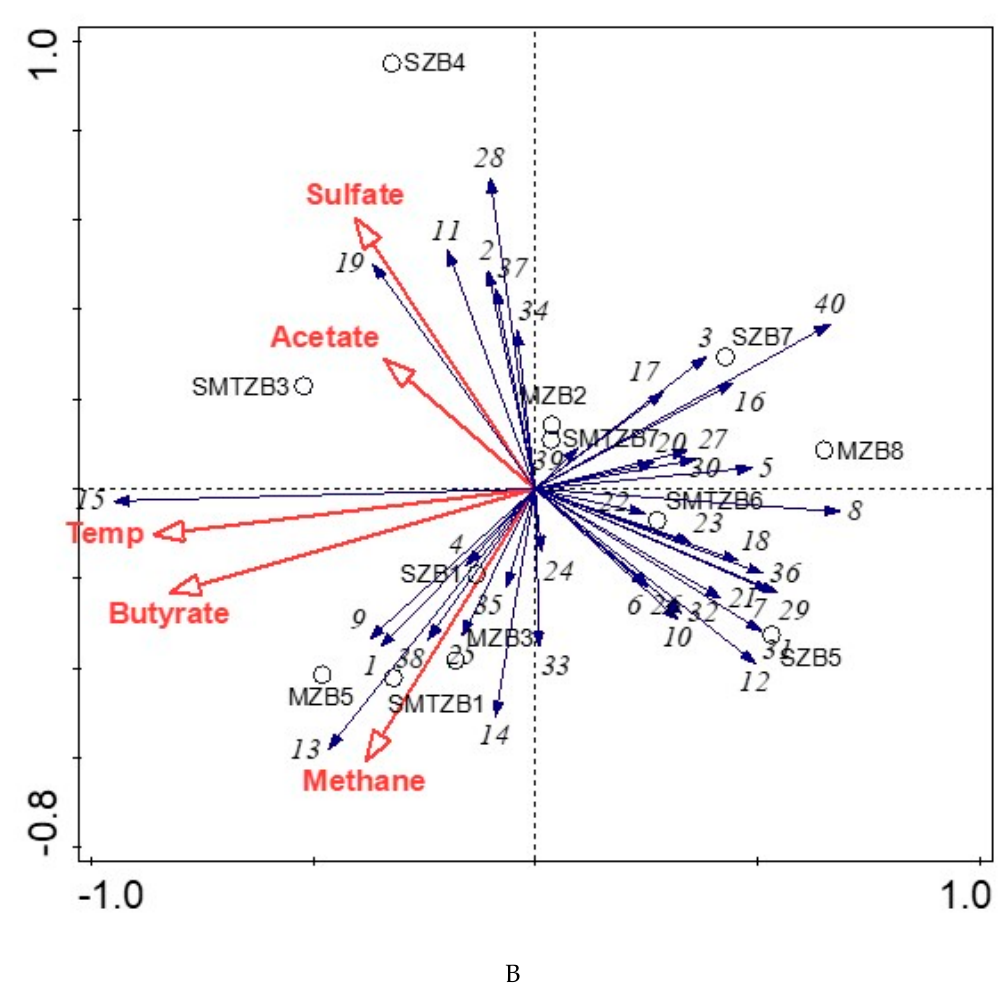
Figure 4. ( A ) The heatmap depicts the relative percentage of the most common (>5 %) bacterial 16S rRNA gene sequences across the 12 slurries analyzed. The heatmap colors represent the relative percentage of the bacterial assignments within each sample. Colors shifted towards dark green indicate higher abundance. Taxonomy is shown at the genus level (unless unassigned) above and at the phylum level below the heatmap. ( B ) Redundancy Analysis Triplot showing relationship between bacterial community composition at order level and environmental parameters. Environmental variables are given as red vectors. Blue vectors represent bacterial orders. Orders were included with a relative abundance of at least 1% in any sample. Vector length gives the variance that can be explained by a particular environmental parameter. Perpendicular distance reflects association, with smaller distances indicating a larger association. Temp: Temperature.